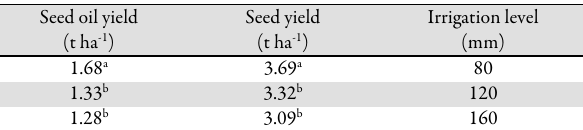
Table 7. The effect of irrigation (mm) level on seed yield and seed oil